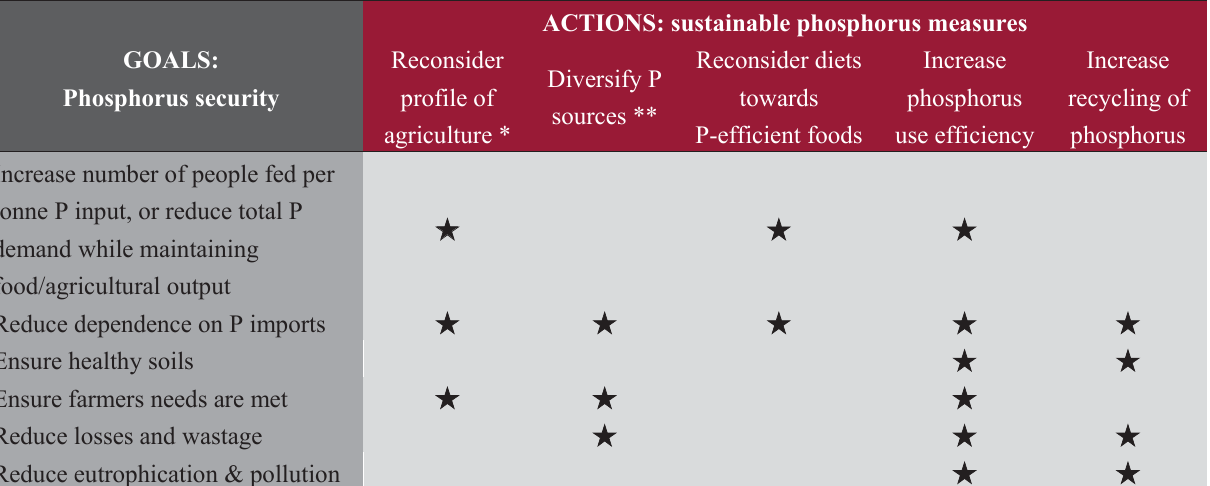
Table 1 highlights which sustainable phosphorus measures can meet which phosphorus security goals. Table 1. Identification of which actions (sustainable phosphorus measures) can address which goals (phosphorus security). Adapted from Cordell et al.